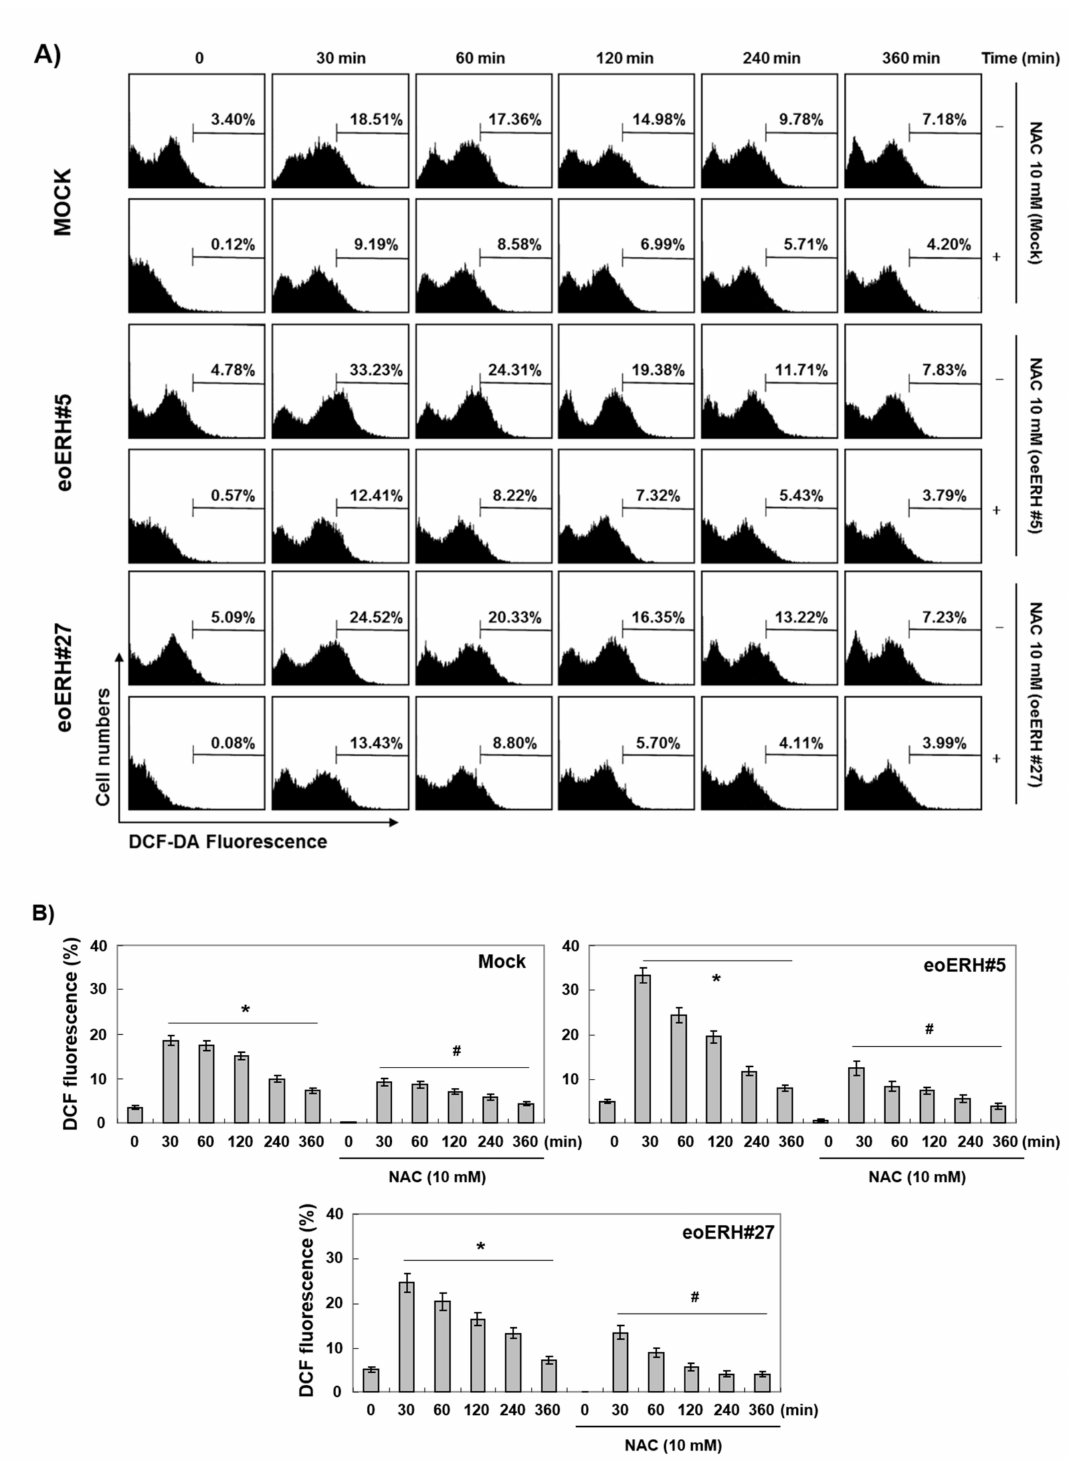
Figure 6. ERH-augmented ROS generation triggered by AIMs. The cells were seeded at the density of 5 × 10 4 cells per mL. The two kinds of E-MKN28 cells (eoERH#5 and eoERH#27) and M-MKN28 cells were treated with AIMs at the concentration of 200 µ g/mL for 48 h. ROS generation triggered by AIMs is the highest at 30 min after AIMs treatment. At this time, ROS generation is much higher in E-MKN28 cells than M-MKN28 cells. ( A ) The data shown in the figure are representative of three independent experiments. ( B ) Summarized flow cytometry data in bar graphs. (*, # p < 0.05 between before and after AIM treatment). M, M-MKN28 cells; 5, eoERH#5 E-MKN28 cells; 27, eoERH#27 E-MKN28